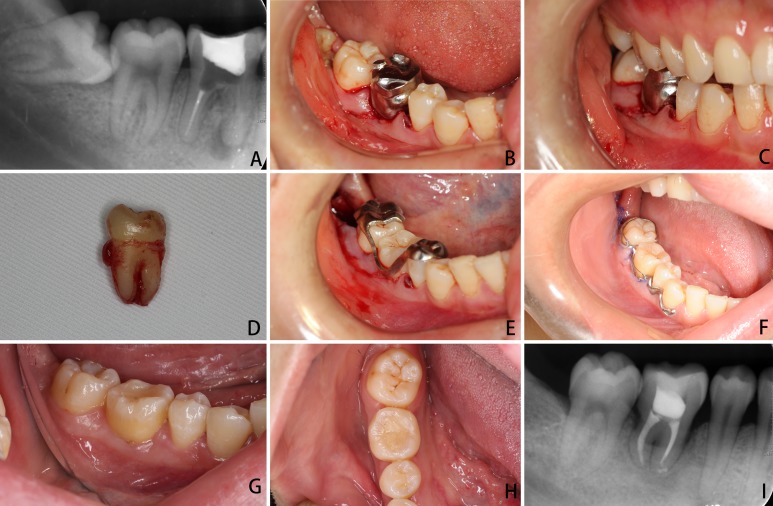
Autotransplantation surgery aided with individual guides.(A) Initial apical film of the first molar and the third molar that was selected to be the donor tooth, (B and C) the new socket at the recipient site was prepared under the guidance of a replica of the donor tooth and a local surgical split, (D) the donor tooth was gently extracted, (E) the donor tooth was immediately transplanted onto the recipient site, and the position of the autotransplanted tooth was checked using an individual surgical template, (F) 1 week after fixation with arch bar, (G and H) 1 year after the autotransplantation surgery: the gingiva was pink and firm and probing depth was ≤3 mm, (I) apical film of the autotransplanted tooth at 1 year.